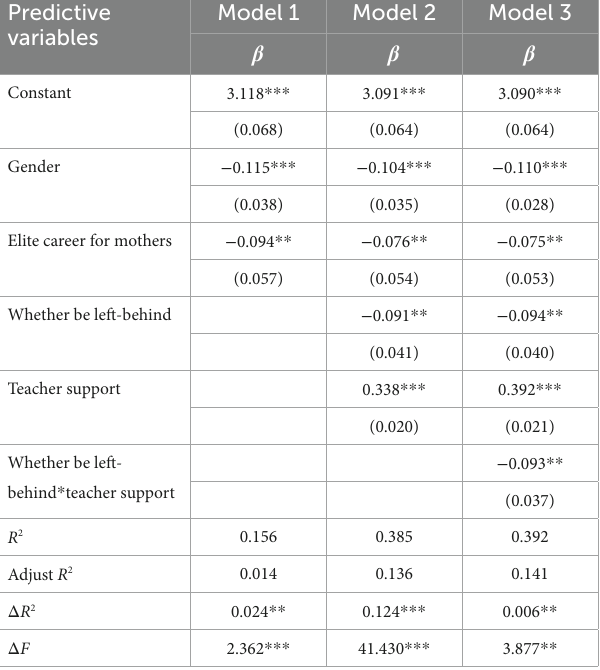
TABLE 8 The moderating effect of teacher support on the SEC development of left-behind